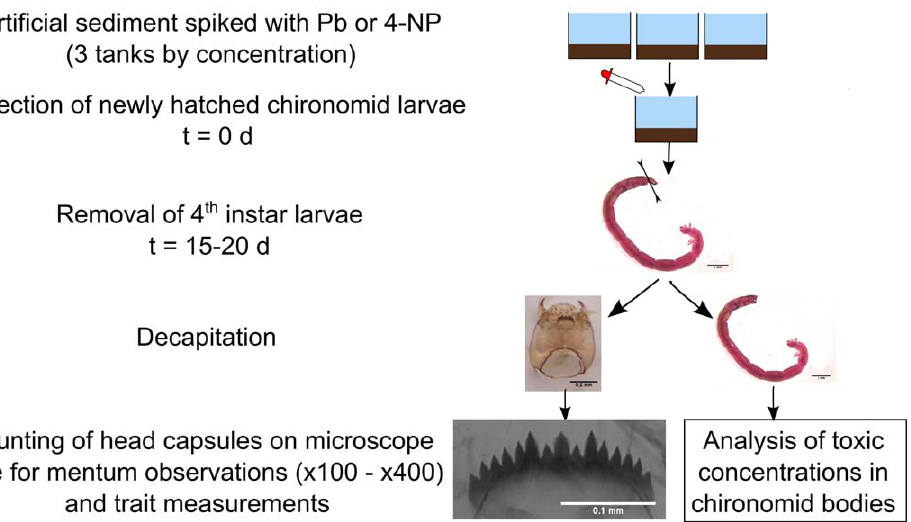
Figure 1. Experimental design of the bioassays conducted. Measurement performed on mentum: 1) frequency of deformities, 2) length FA, 3) shape FA and 4) mean shape changes.